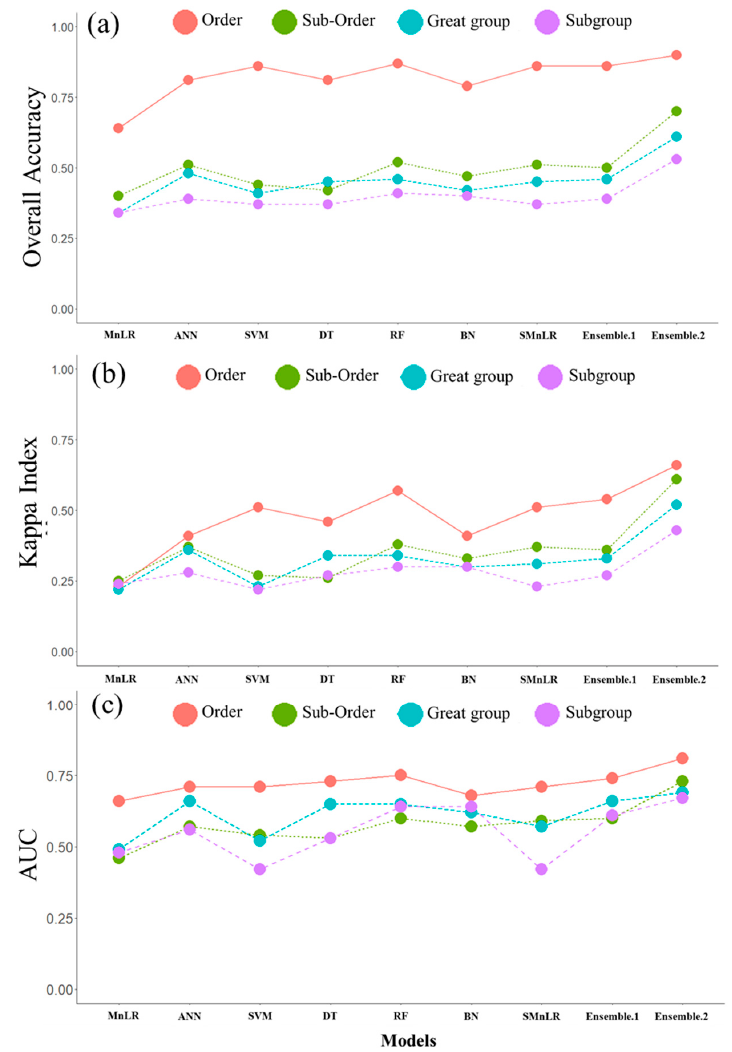
Figure 2. The overall accuracy ( a ), kappa index ( b ) and area under the curve (AUC) ( c ) of all models for different levels of soil taxonomic.